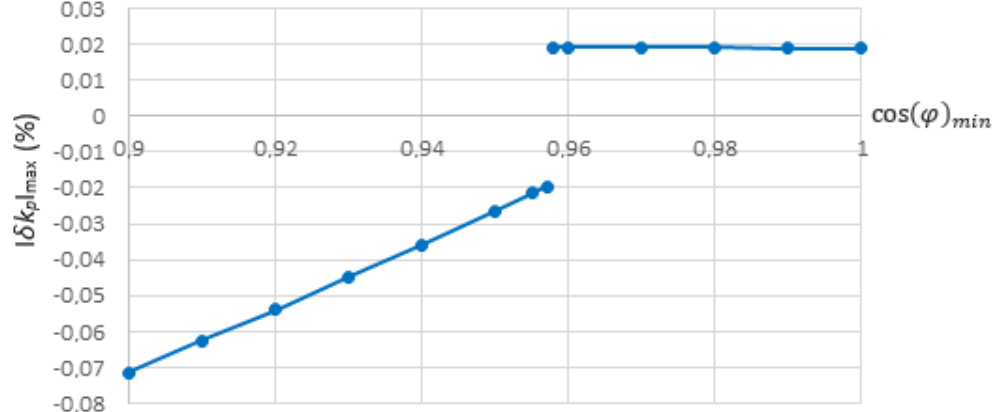
Figure 11. Dependence of the wattmeter gain WCE on power factor in the range of a load power factor 0.9 ≥ cos(𝜑) 𝑚𝑖𝑛 ≥ 1 . Table 2. The adjustment gain relative error dependence on the maximum rated load power 5 kW, 7 kW, and 10 kW.